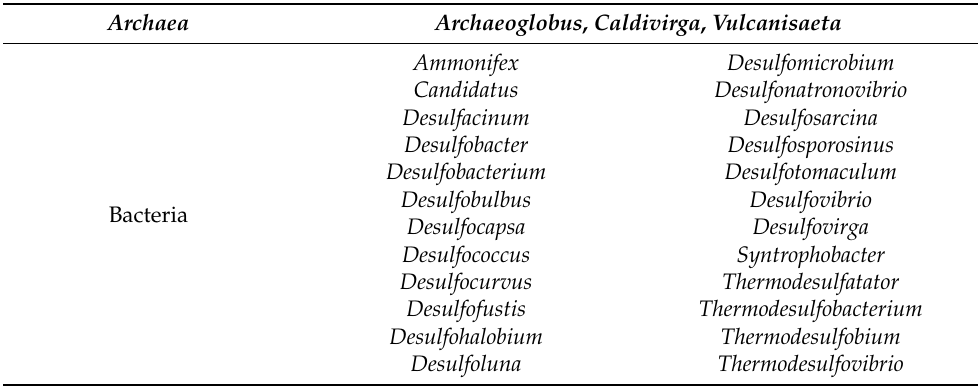
Table 2. Examples of representatives of the group of sulfate-reducing organisms [90]. Archaea Archaeoglobus , Caldivirga , Vulcanisaeta